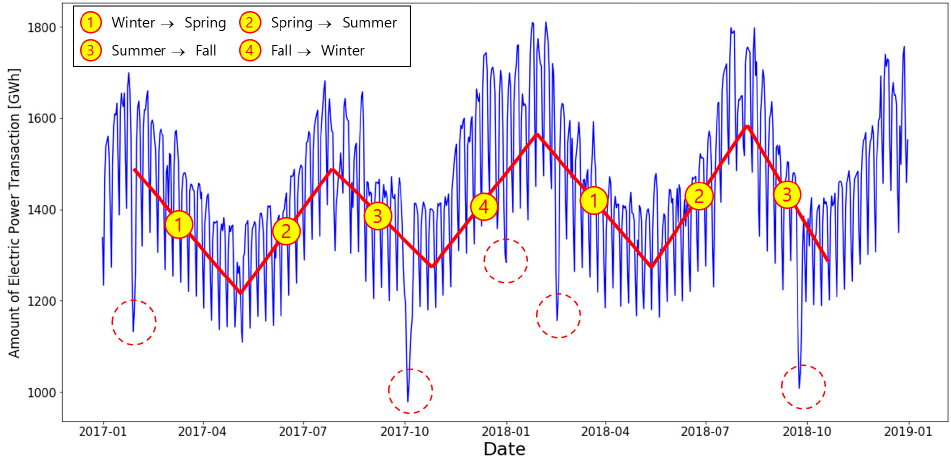
Figure 4. Characteristics of EPT from 2017 to 2018.